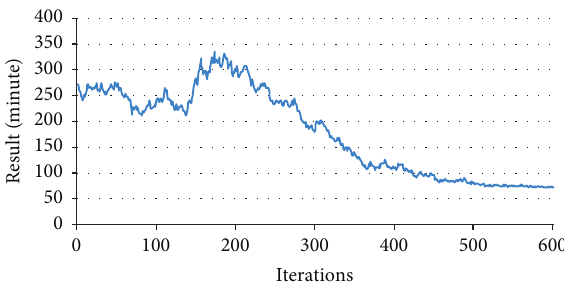
Figure 5: The value of result in each iteration. Table 9: The detailed comparison results for two kinds of methods (unit: pax).